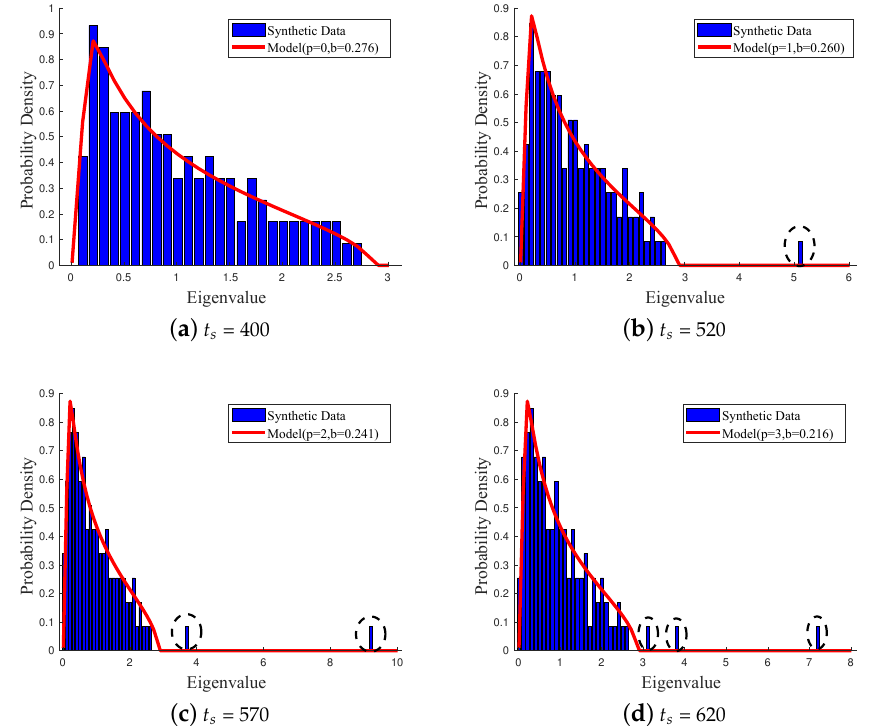
Figure 3. The ESD of the covariance matrix of ˜ X at different sampling points in Case 3. The bulk can be fitted well by our built model with ˆ b . The numbers of spikes are different when different numbers of constituent components occurring within a multiple event, which is consistent with the results in Table